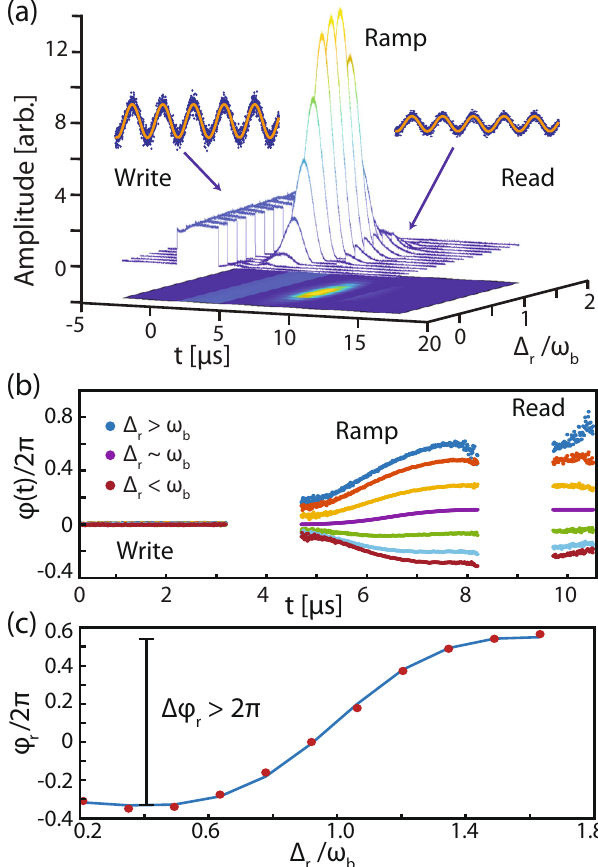
Fig. 4 Tuning the phase of the retrieved pulse. a Amplitude of the acquired signals vs. time and reservoir detuning for the phase-manipulation experiment. In this experiment, no optical fi ltering was used, so that the write, ramp, and read pulses may all be detected. b Phase of the mechanical oscillator vs. time as inferred from the optical output of the device. c Final phase as a function of Δ r along with a fi t to the data based on the predicted temporally varying optical spring effect associated with the ramp